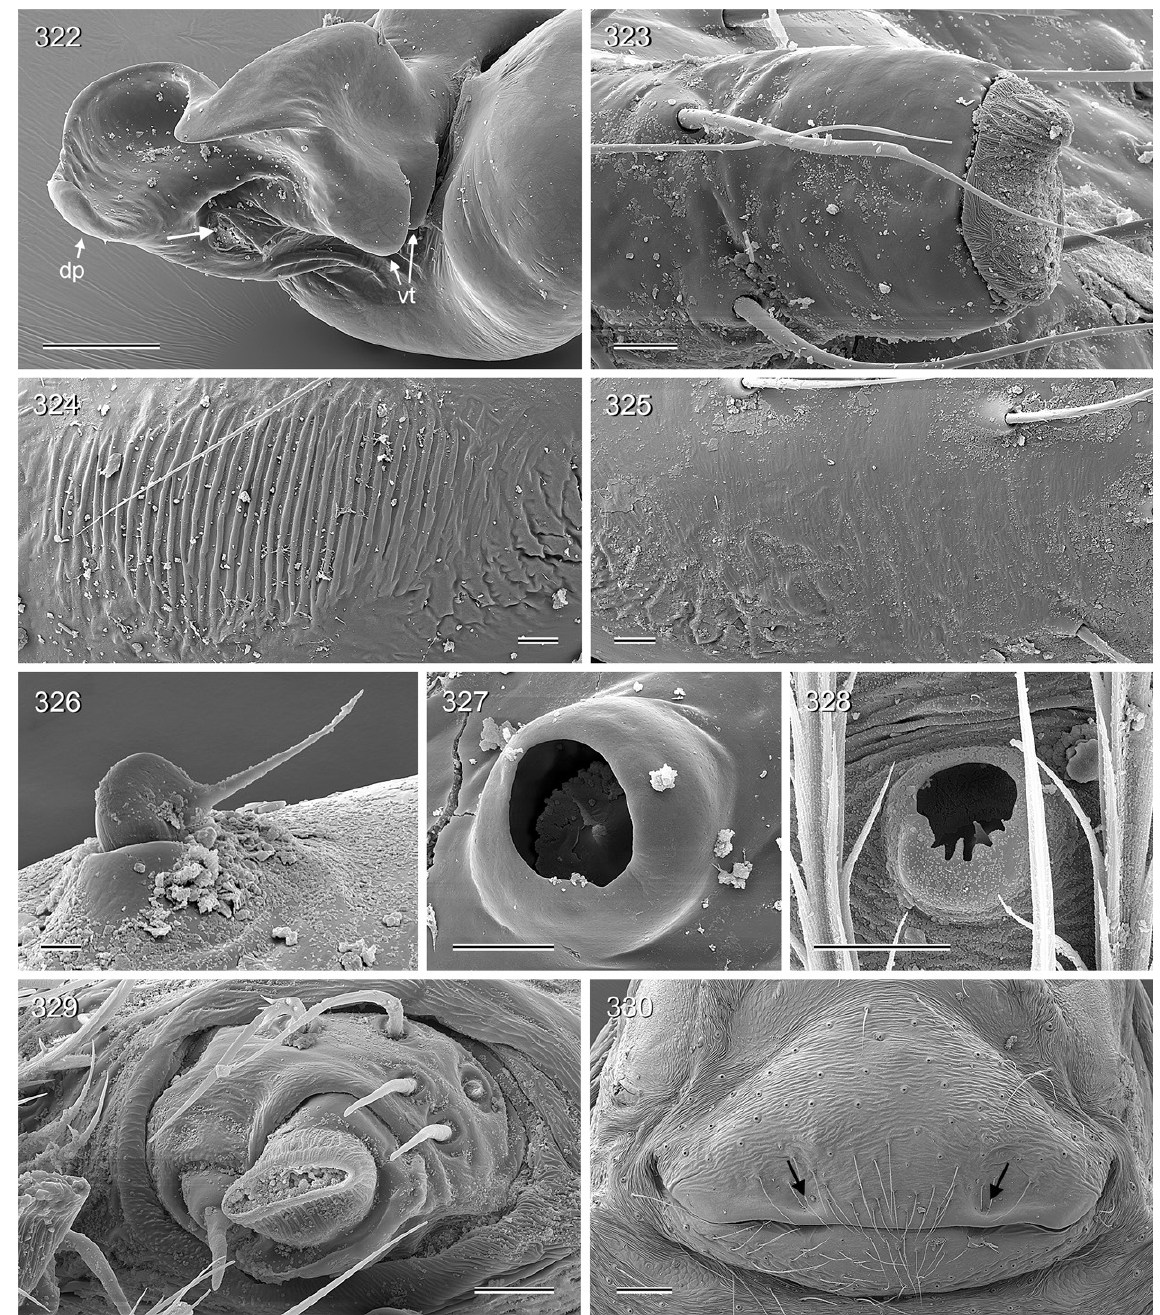
Figs 322–330. Maghreba aurouxi (Barrientos, 2019) gen. nov.; male and female from Morocco, SE of Zebzat (ZFMK Ar 22385, Ar 22386). 322 . Left genital bulb, ventral (slightly distal) view; arrow: sperm duct opening. 323 . Male cheliceral apophysis. 324–325 . Male stridulatory file and corresponding largely smooth female cheliceral side. 326 . Stridulatory pick on female palpal femur. 327 . Male palpal tarsal organ. 328 . Tarsal organ on male tarsus 3. 329 . Female ALS. 330 . Epigynum; arrows: pockets (pits). Abbreviations: dp = dorsal process; vt = ventral teeth. Scale bars: 322, 330 = 100 µm; 323–325, 327–329 = 10 µm; 326 = 2